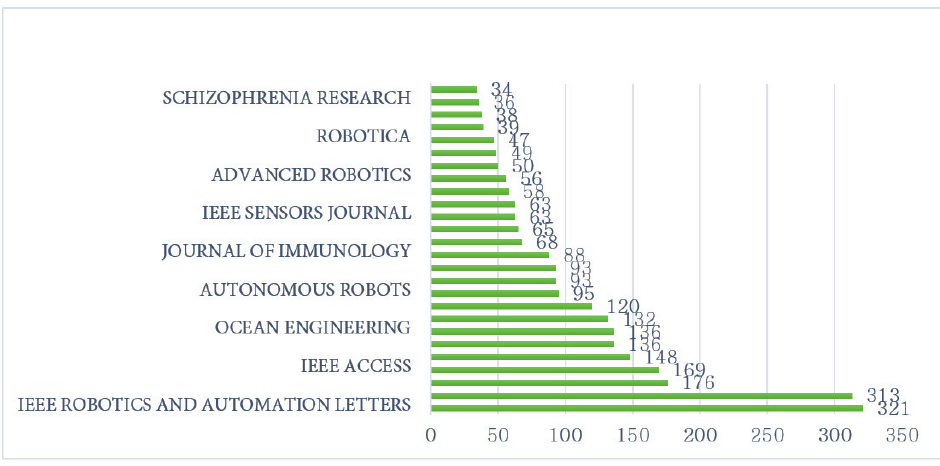
Figure 9. Titles of publications on SLAM in the Web of